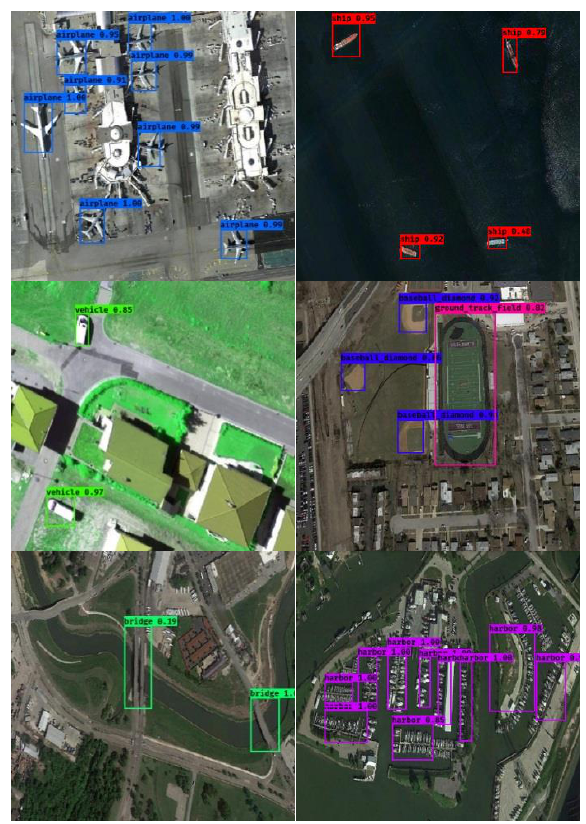
Figure 8. Detection results of NWPU VHR-10 dataset Results and performances of airport detection and airplane detection are shown in Figure 6-7 and Table 1-2. Results of object detection of NWPU VHR-10 dataset are shown in Fighre 7.